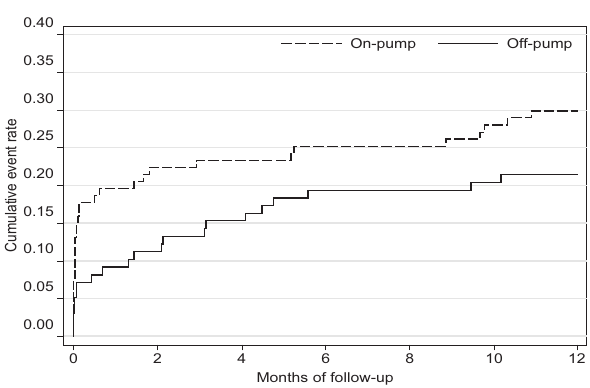
Fig. 1. Kaplan-Meier curves. The incidence of combined pri- mary end point during the first postoperative